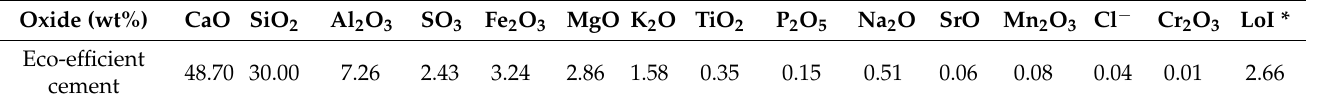
Table 6. XRF-determined chemical composition of eco-efficient cement.